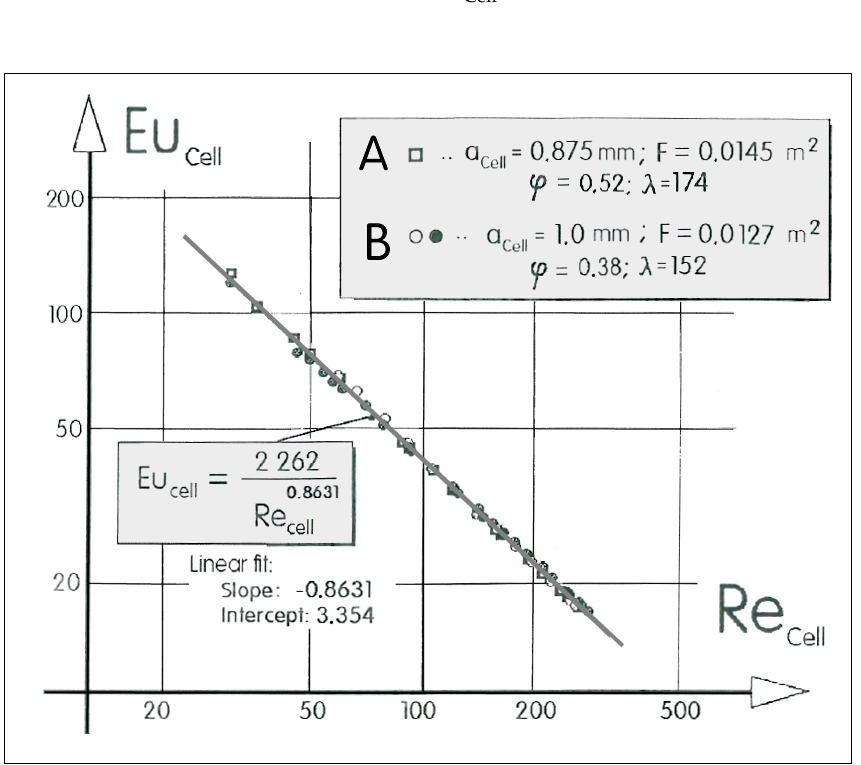
Figure 8. Data from Figure 7 non-dimensionalized—plotted as dependence of Euler number on cell Reynolds number. They could be fitted by the single universal power law line.